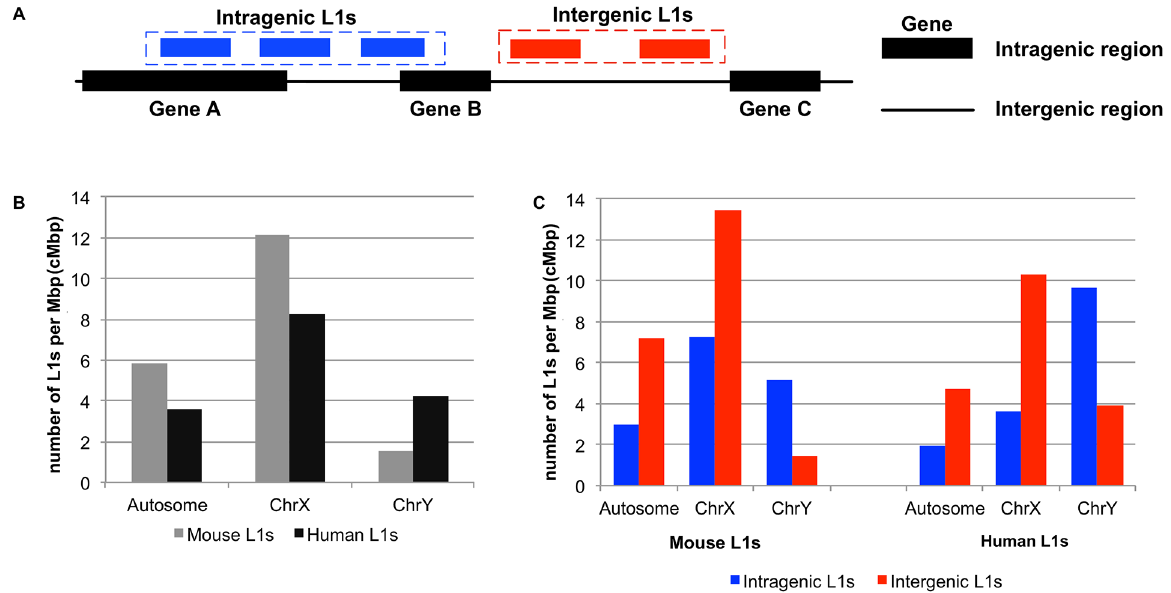
Figure 1. Distribution of mouse and human L1s over their genomes. (A) Graphical definition of intragenic and intergenic L1s. An intragenic L1 is represented by a blue box, while the intergenic one is represented in a red box. The black box represents a gene (intragenic region) and the black line represents an area outside (intergenic region) the gene bodies. (B) A bar graph shows the distribution of mouse (gray columns) and human (black columns) L1s residing on autosome, X, and Y-chromosomes. (C) Two side-by-side bar graphs comparing intragenic (blue columns) vs. intergenic (red columns) L1s on mouse and human genomes.